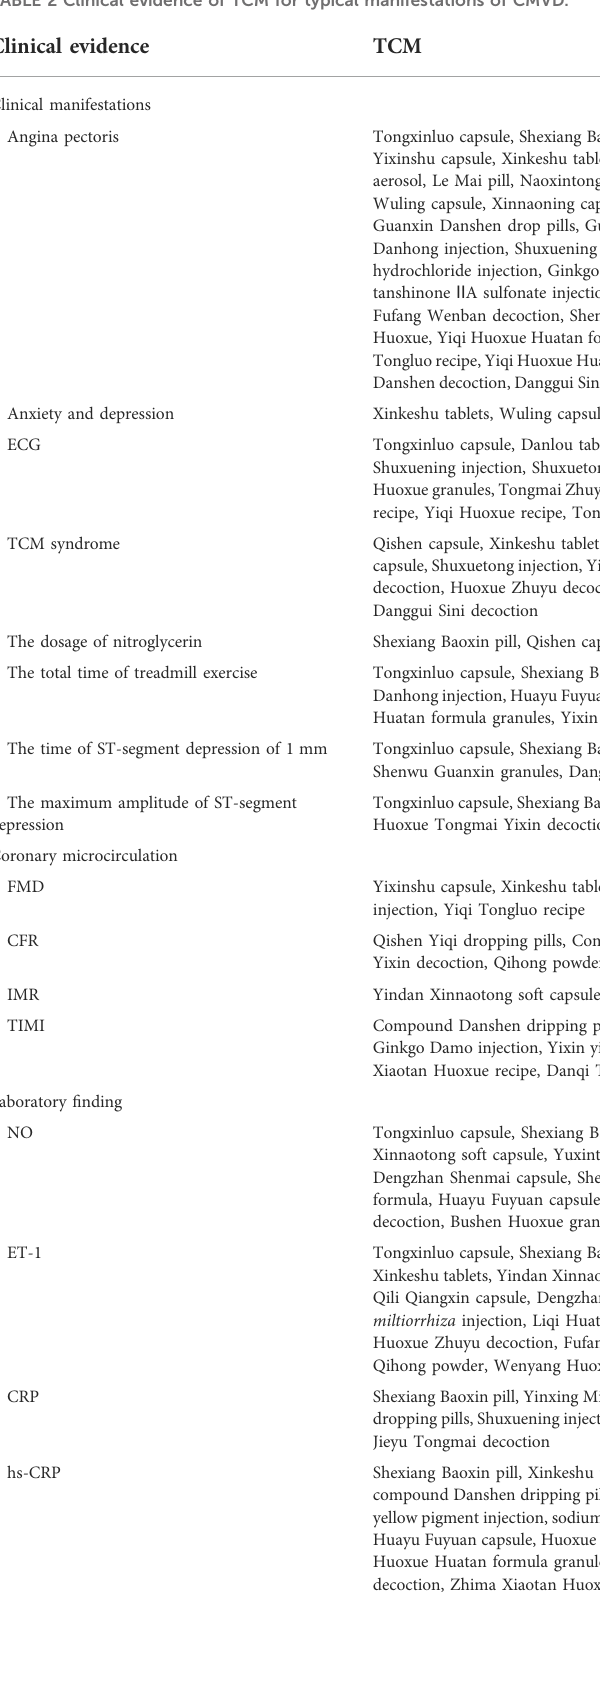
TABLE 2 Clinical evidence of TCM for typical manifestations of